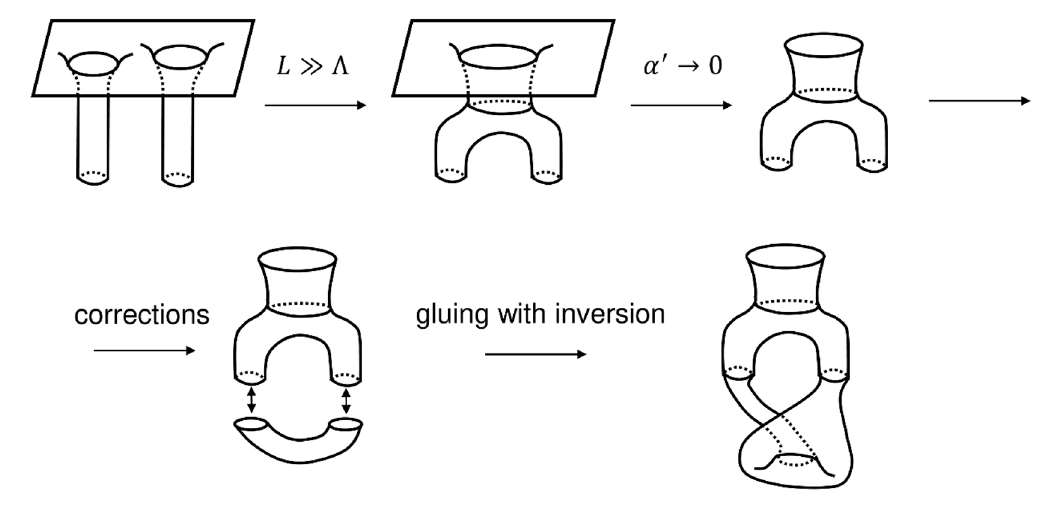
Figure 1 . Perturbative construction of an AdS wormhole solution in a single asymptotic space by taking the decoupling limit of two stacks of D3-branes and correcting for the finite temperature caused by the thermofield double entanglement structure below the scale Λ . Figure inspired by the near-horizon limit as depicted in [18,